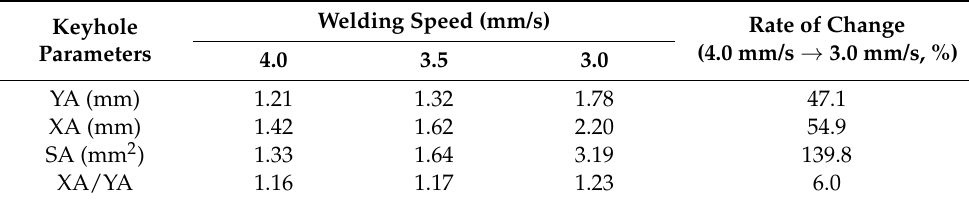
Table 3. Mean value of keyhole characteristic parameters under different welding speeds.